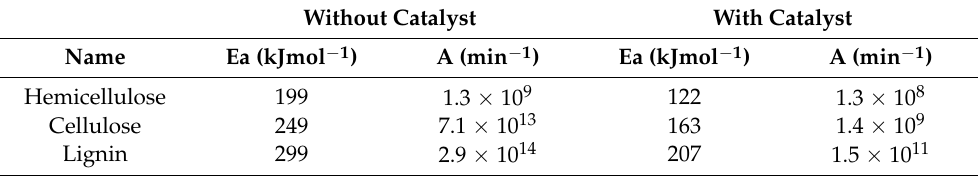
Table 3. Ea and A values calculated from the pyrolysis of PP using the Kissinger model . Without Catalyst With Catalyst